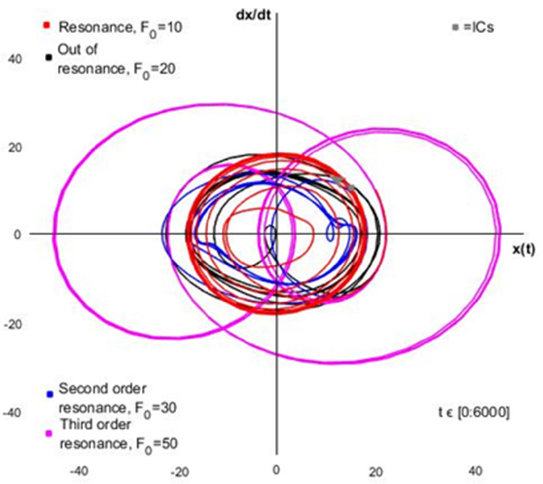
Figure 5. Phase plane diagram for systems at various degrees of resonance and realistic values of F 0 , subjected to loading expressed by Equation (6). Reproduced from [13], Published by IOP Publishing 2017.